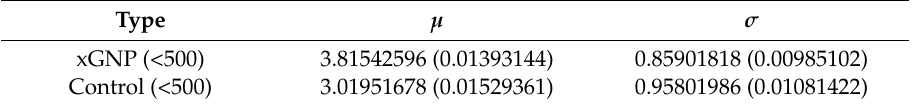
Table 2. Parameter estimates of µ and σ with their standard errors.